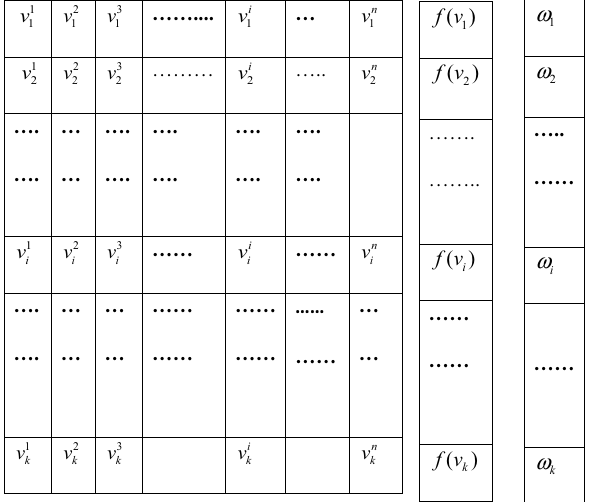
⋯ 𝜔 ⋯ 𝜔 𝜔 𝜔 1 ≥ 2 ≥ i ≥ i ), from top to ⋯ f ( v ⋯ ≤ f ( v 2 ) k